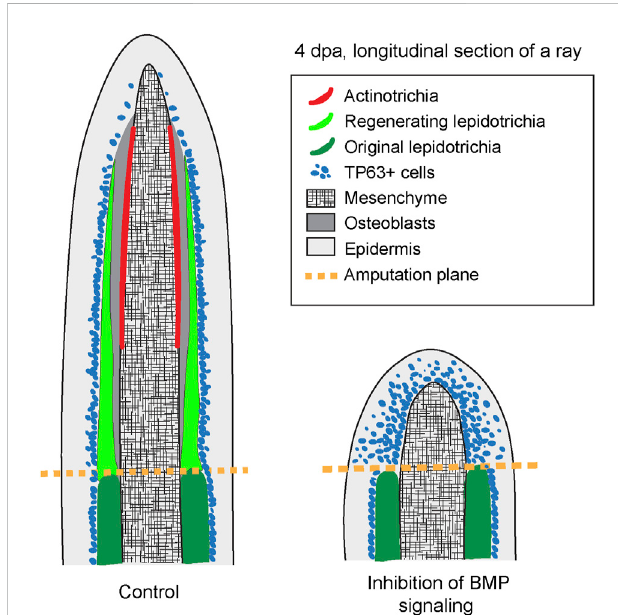
FIGURE 8 A schematic summary of the phenotype caused by the inhibition of BMP signaling during outgrowth formation following fi n amputation in platy fi sh. The schematic is based on immuno fl uorescence staining of fi n sections at 4 dpa. Pharmacological inhibition of BMP signaling prevents regeneration of actinotrichia and lepidotrichia. Furthermore, the nuclear marker of the basal epidermal layer, Tp63, is abnormally detected throughout all layers of the wound epidermis in LDN193189- treated fi ns, suggesting an abnormality in the differentiation of this